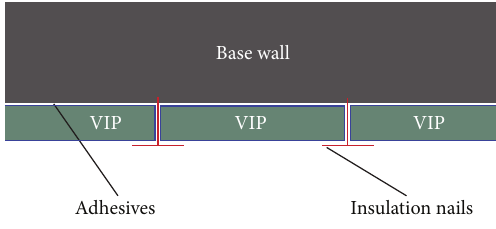
Figure 15: Anchorage of VIP.